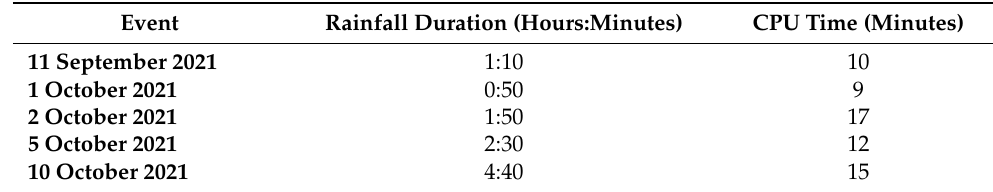
Table 4. Computational CPU